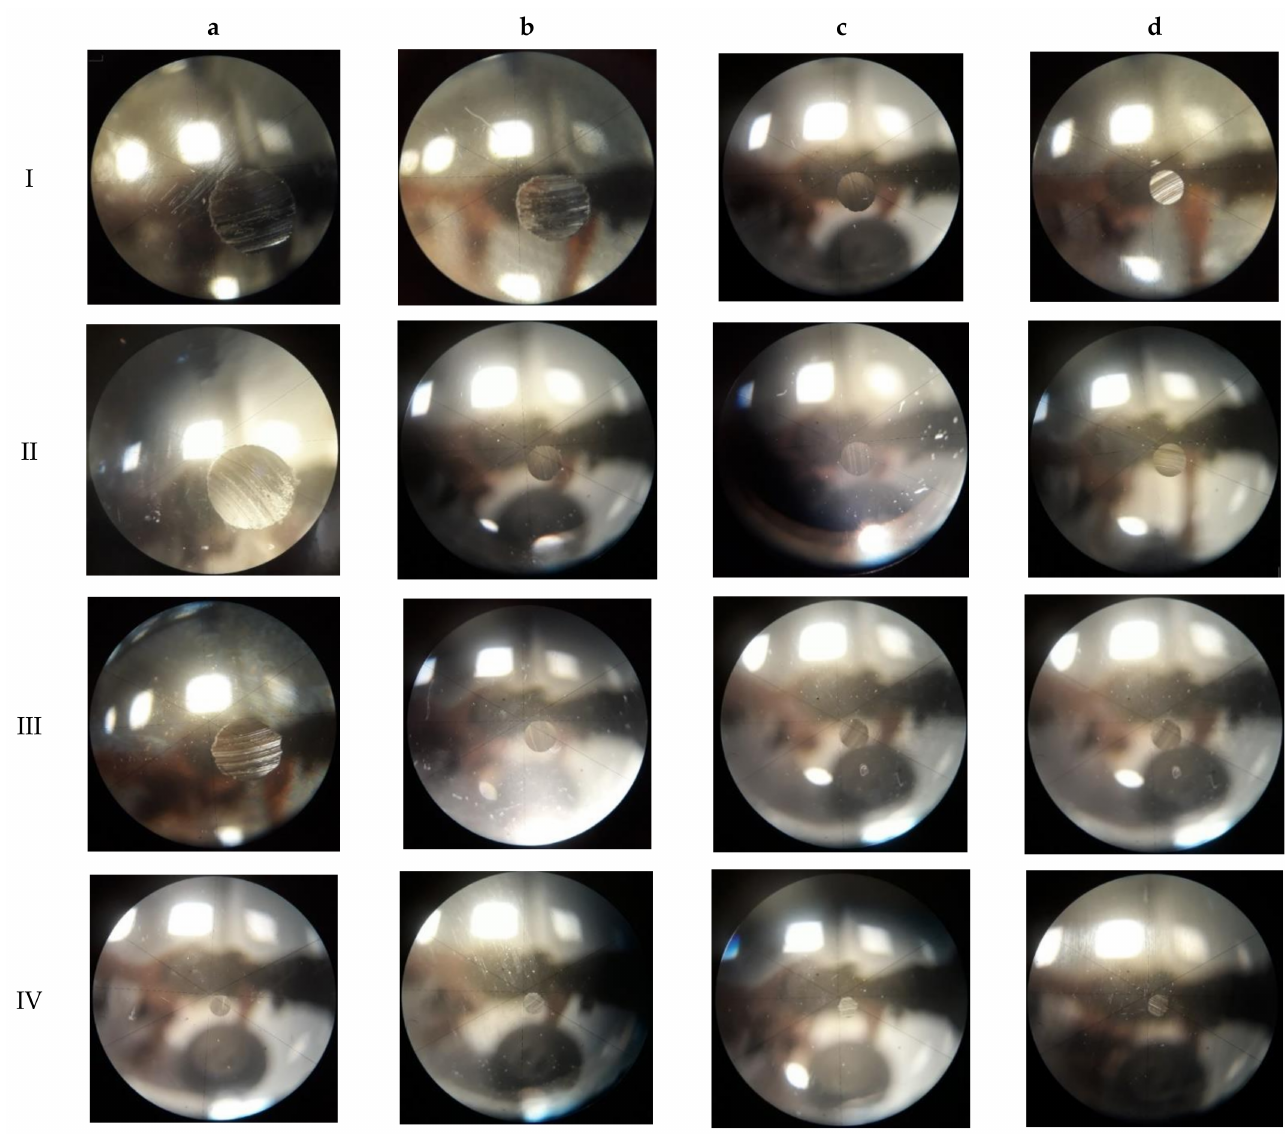
Figure 4. Pictures of sample wear spots following the test for samples are presented in Table 6.